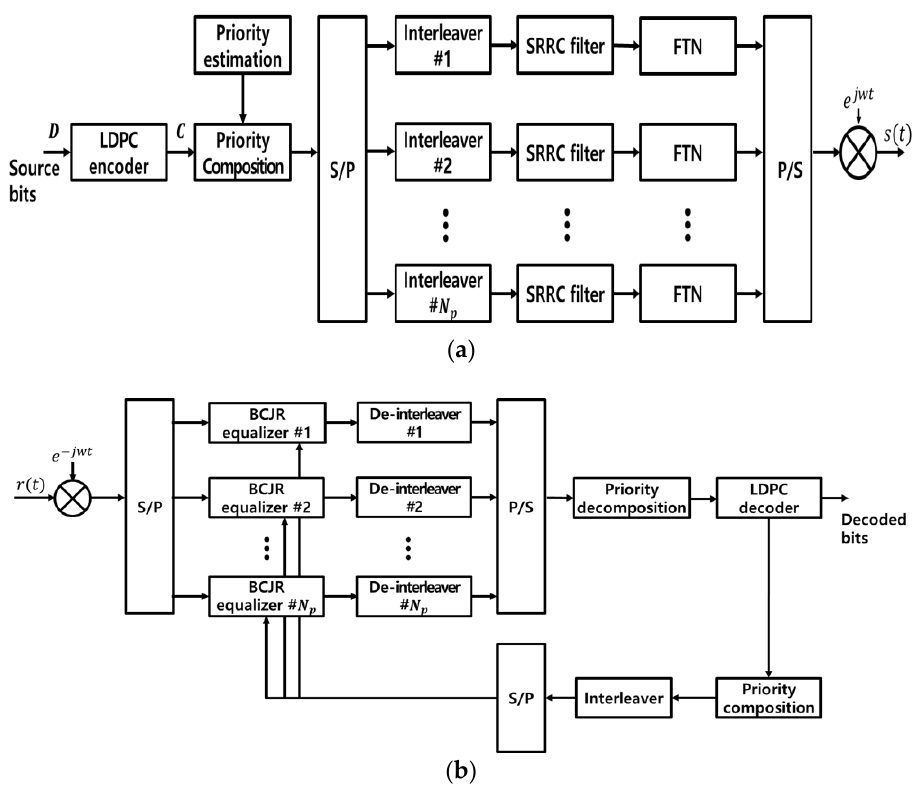
Figure 3. The transceiver structure of the FTN model based on the UEP algorithm: ( a ) Transmitter; ( b ) receiver.